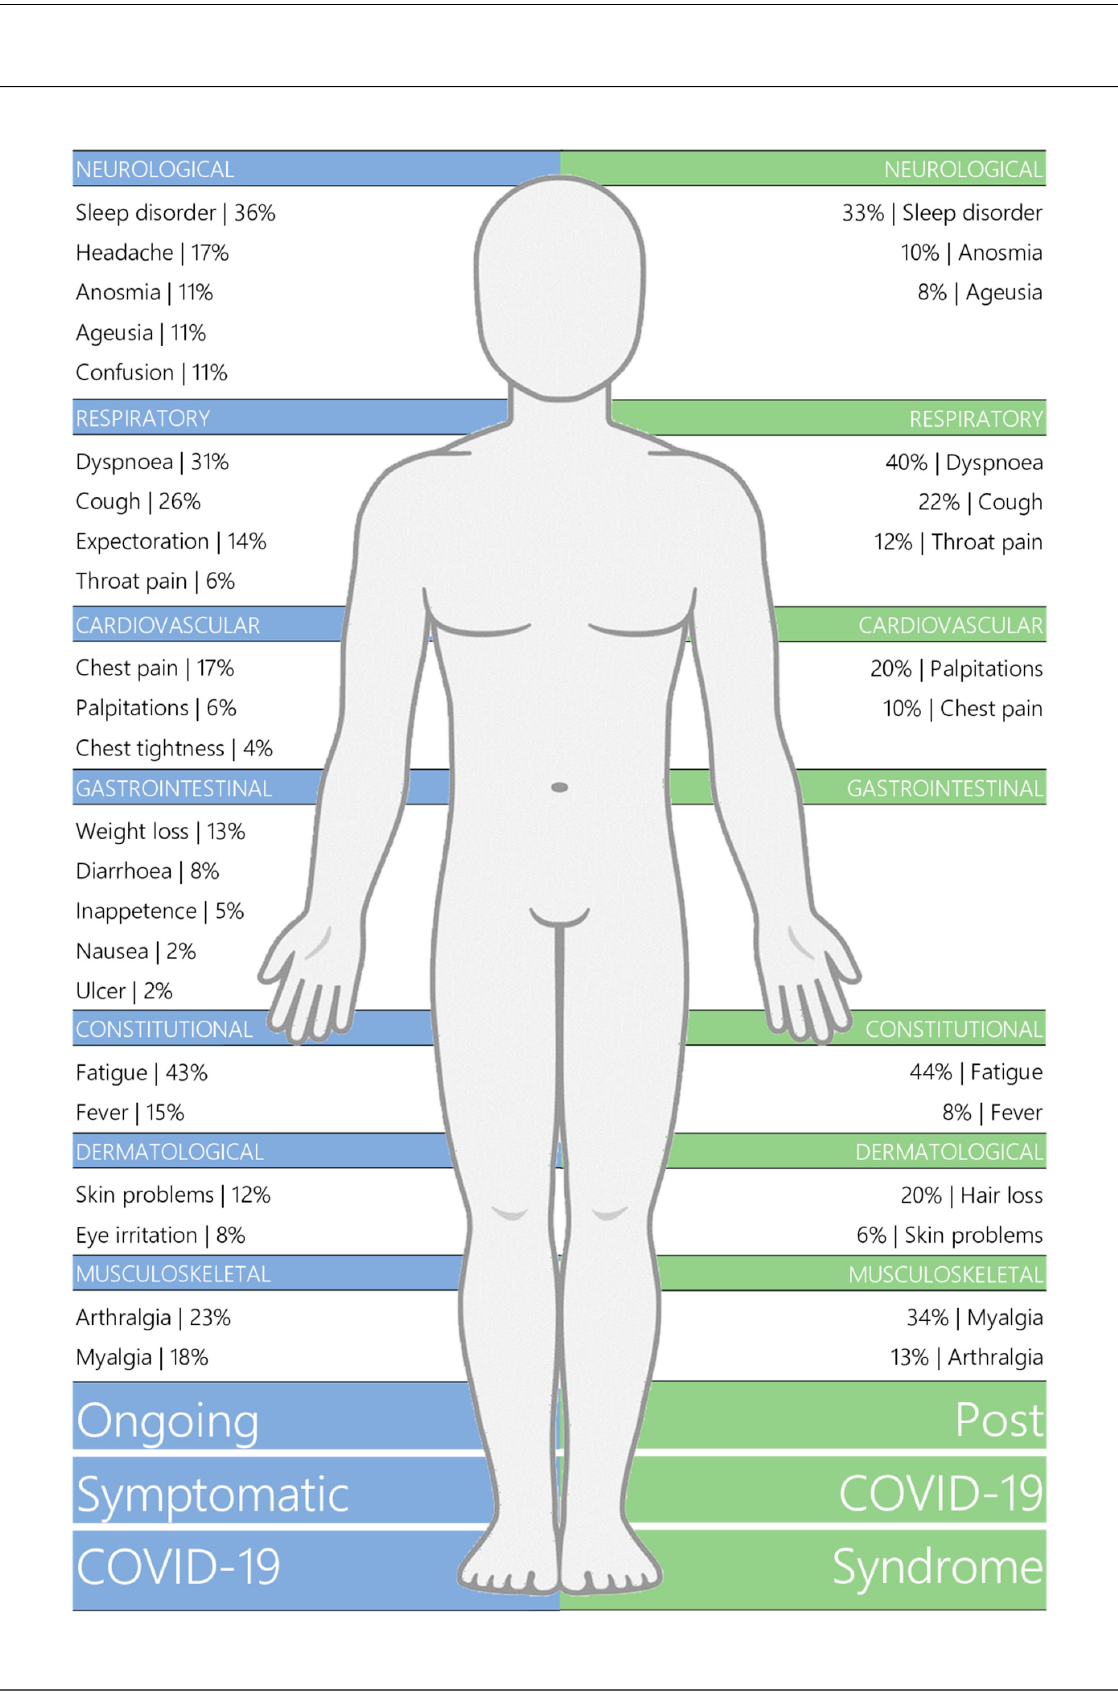
Figure 3. Body Chart of Long COVID Symptomatology.